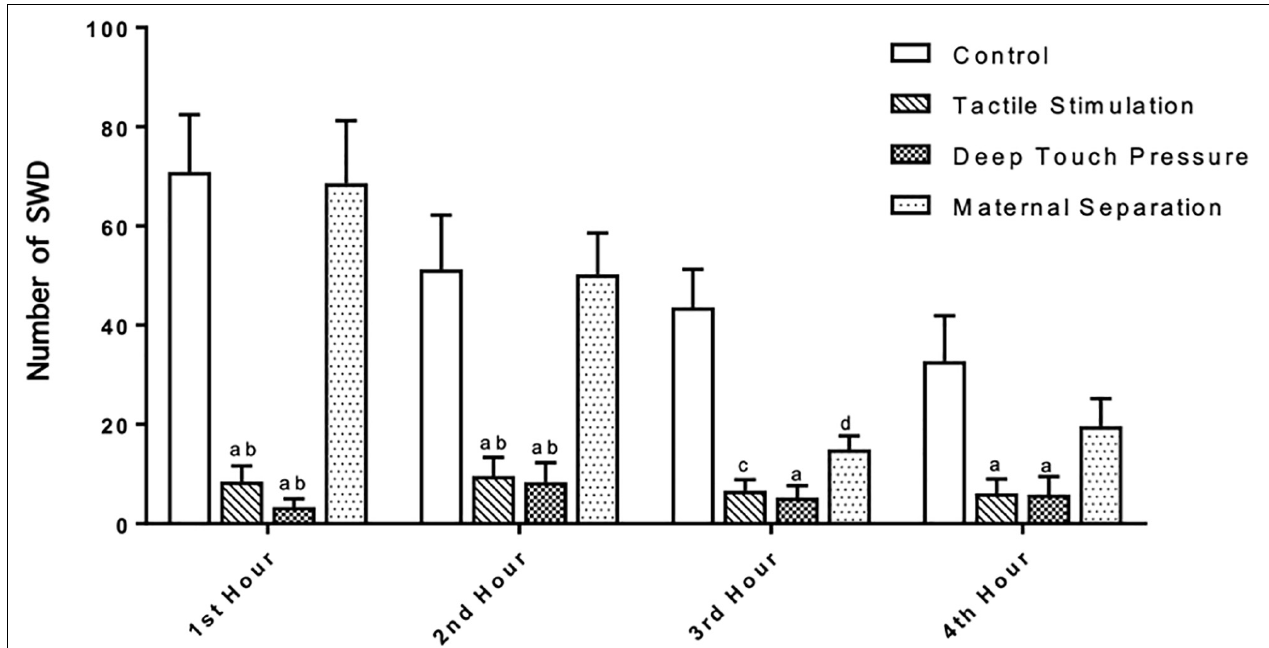
FIGURE 6 | Neonatal TS and DTP influences the number of SWDs in adult WAG/Rij rats. The data are presented as mean ± SEM ( n = 8 per group). Rats underwent TS and DTP showed less SWD in their EEG at 1st and 2nd hour of recordings compared to control ( a p < 0.001) and MS groups ( b p < 0.001). TS ( c p < 0.005),